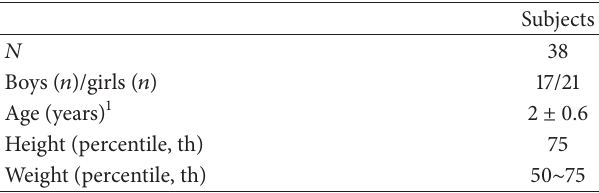
Table 1: Subject characteristics.